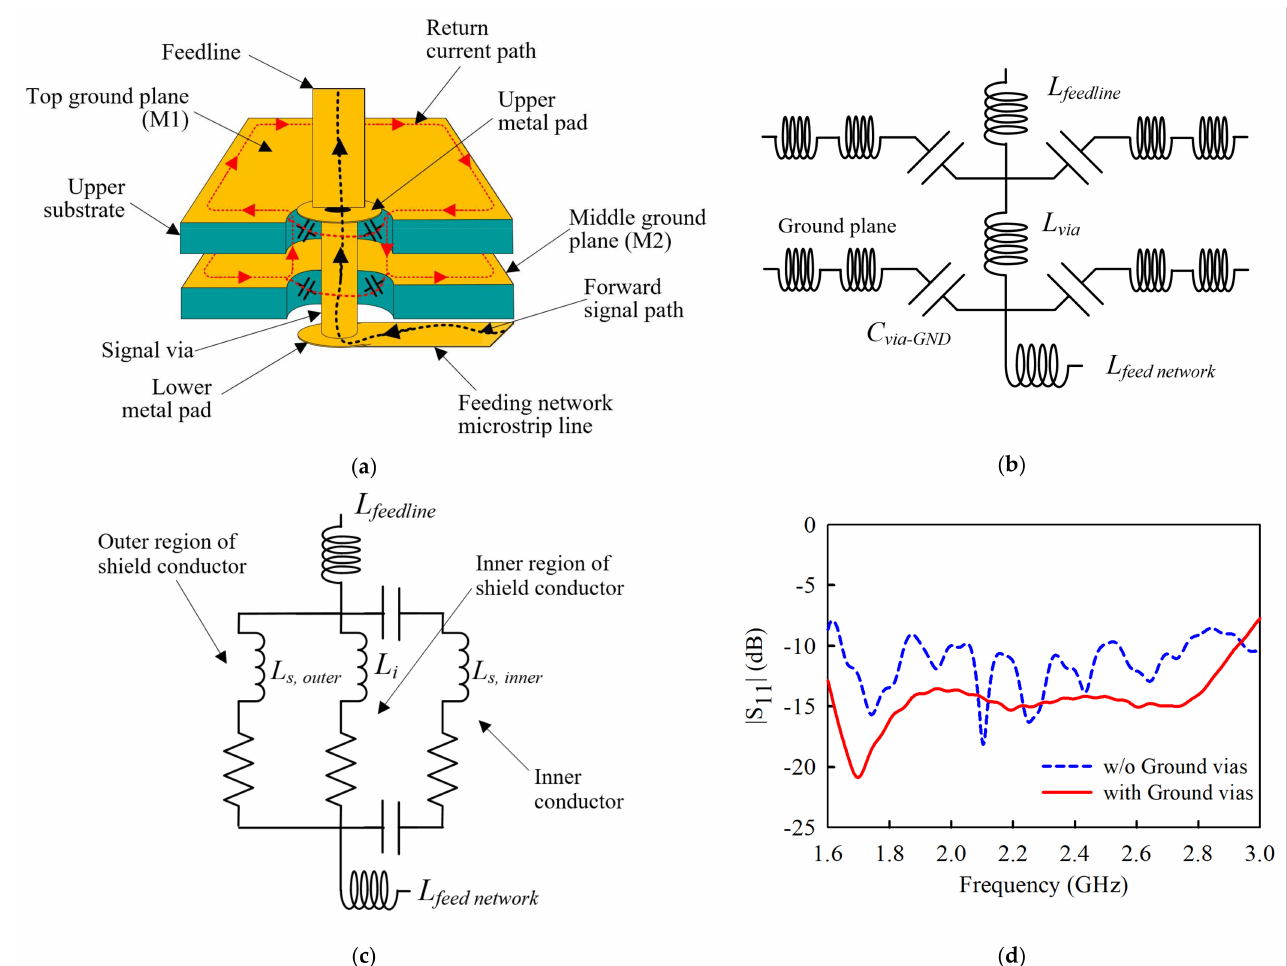
Figure 7. Proposed through-hole signal via (THSV) interconnection for the PCD antenna feeding scheme: ( a ) 3D model; ( b ) Circuit model of proposed case with THSV; ( c ) Circuit model of conventional case with coaxial bead; ( d ) The influence of the ground vias on the antenna’s reflection